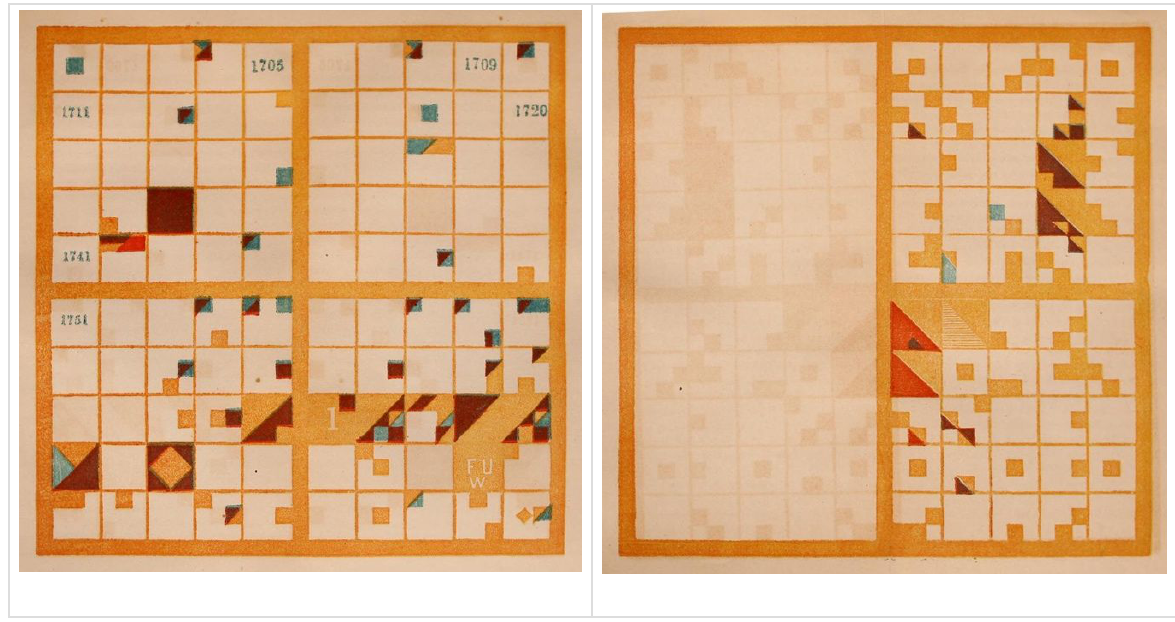
Figures 1–4 (left to right, top to bottom). The four chronological charts included in Elizabeth Palmer Peabody’s Chronological History of the United States (1856a), which display the significant events of the 1500s, 1600s, 1700s, and 1800s. Images courtesy of the Internet Archive. Digitized by the Library of